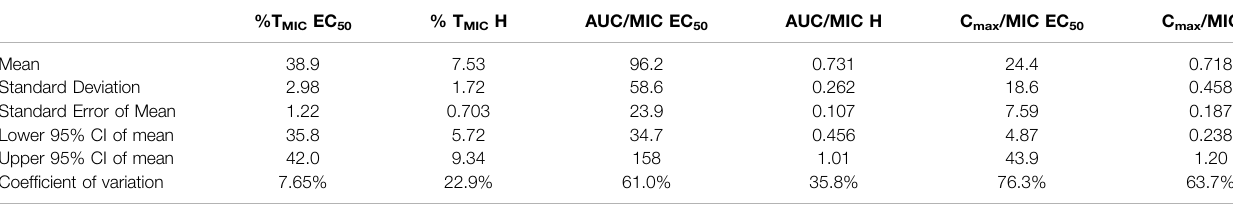
EC, effective concentration; H, Hill coef fi cient.